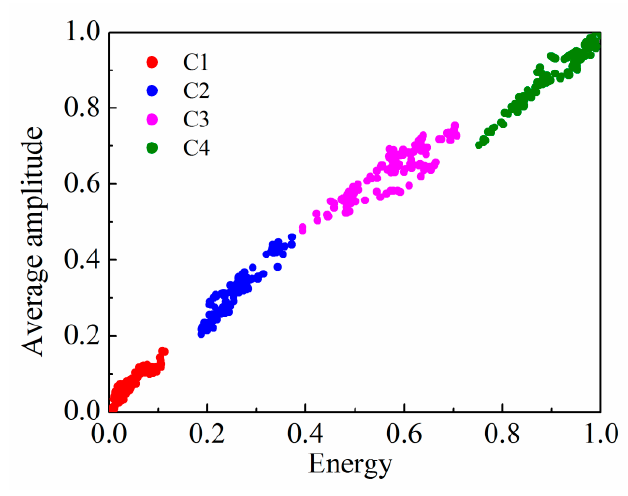
Figure 5. AP-DBSCAN results of three kinds of railing intrusion behaviors.